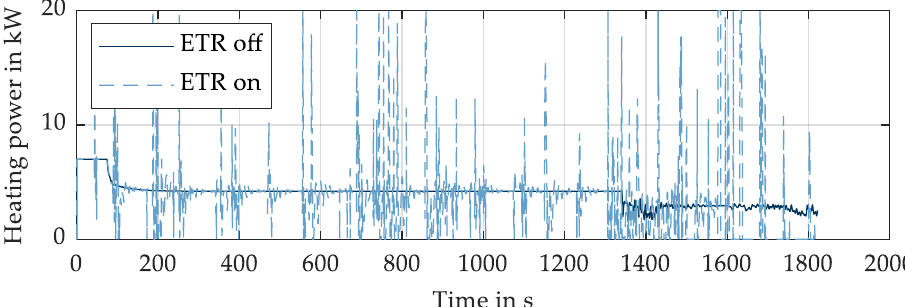
Figure 7. Power consumption of the coolant heater in one FTM cycle at −10 °C. ETR: Electrothermal recuperation.